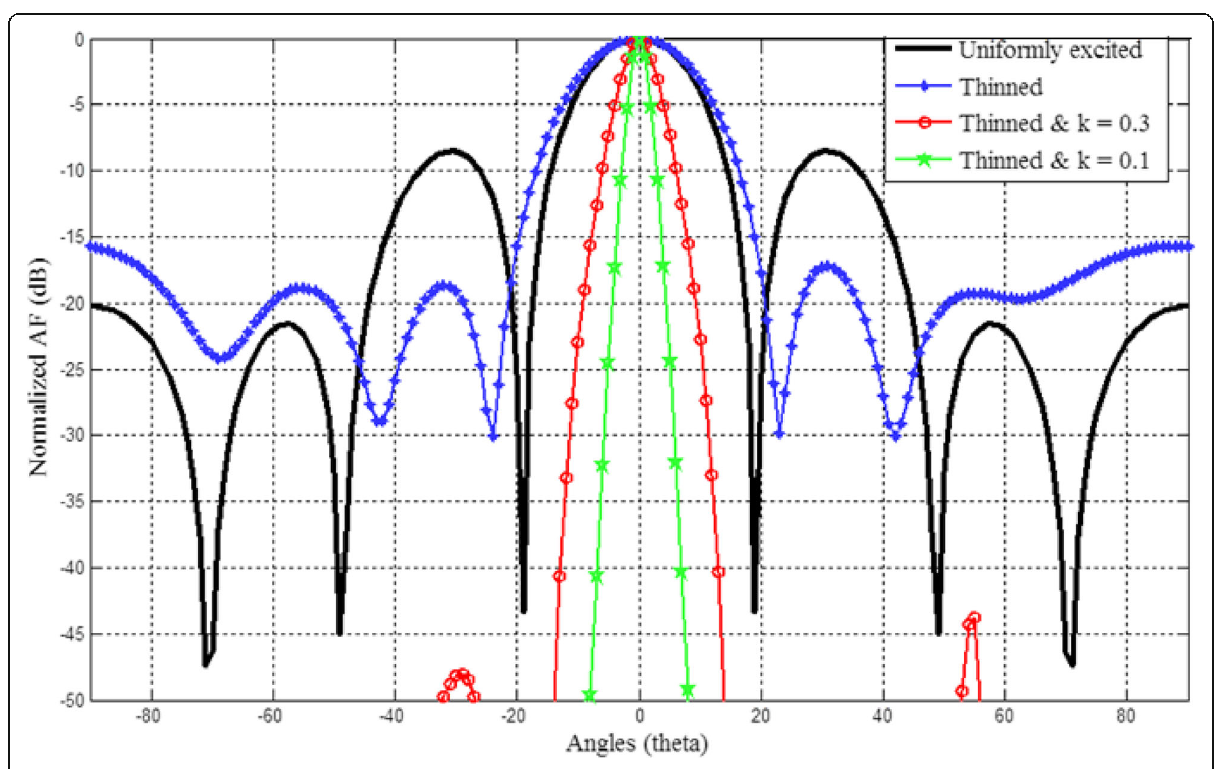
Fig. 3 Thirty-six elements of EcAA with 17 elements turned